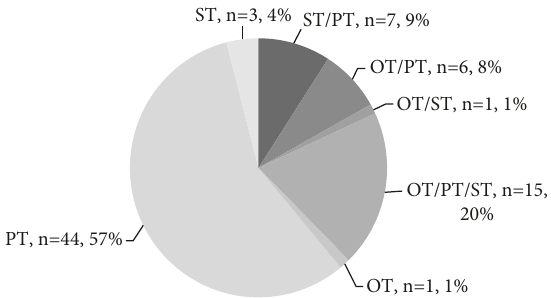
Figure 1: Distribution of all PwEP seen in 2018 ( n � 77). Number of disciplines seen by each patient. Note . OT � occupational therapy; PT � physical therapy; PwEP � people with Parkinson’s disease; ST � speech